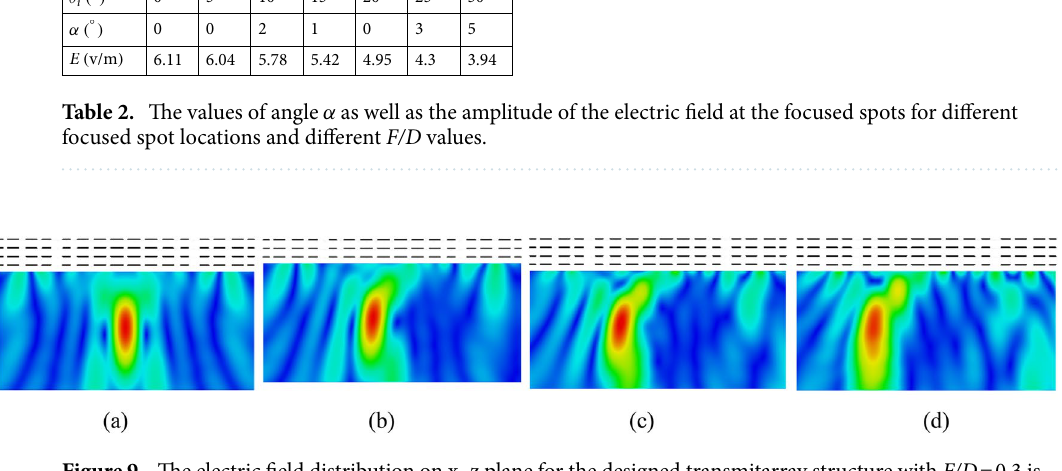
Figure 9. The electric field distribution on x–z plane for the designed transmitarray structure with F/D = 0.3 is illuminated by a plane wave with ( a ) θ i = 0 ◦ , ( b ) θ i = 10 ◦ , ( c ) θ i = 20 ◦ , and ( d ) θ i = 30 ◦